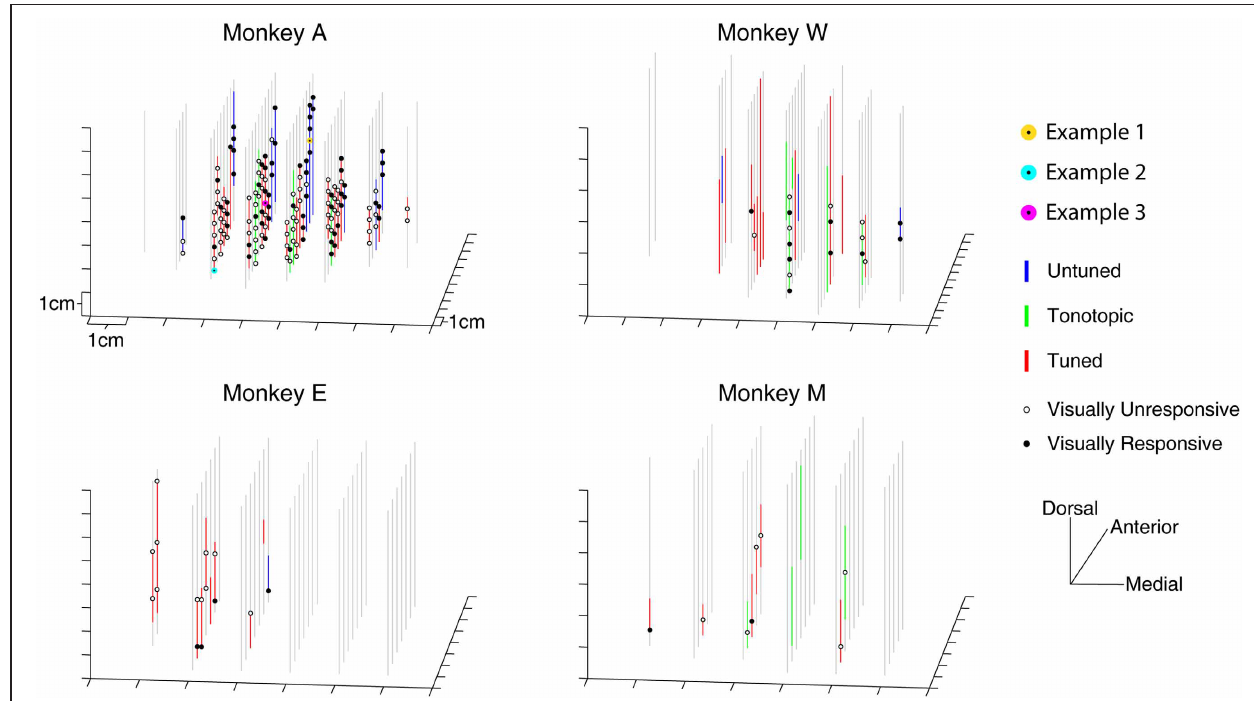
FIGURE 3 | Three dimensional map of locations of tested and responsive recording sites. The location of visually sampled sites are portrayed in a three dimensional representation. Auditory responsive regions are indicated with colored lines untuned penetrations: blue lines; tonotopic penetrations: green lines; tuned penetrations: red lines; (Bulkin and Groh, 2011). Sites that